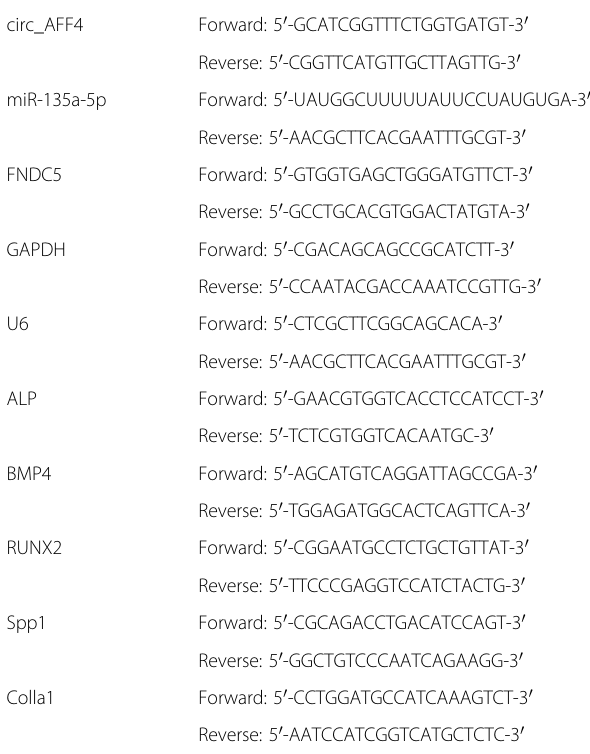
Table 1 The primers in